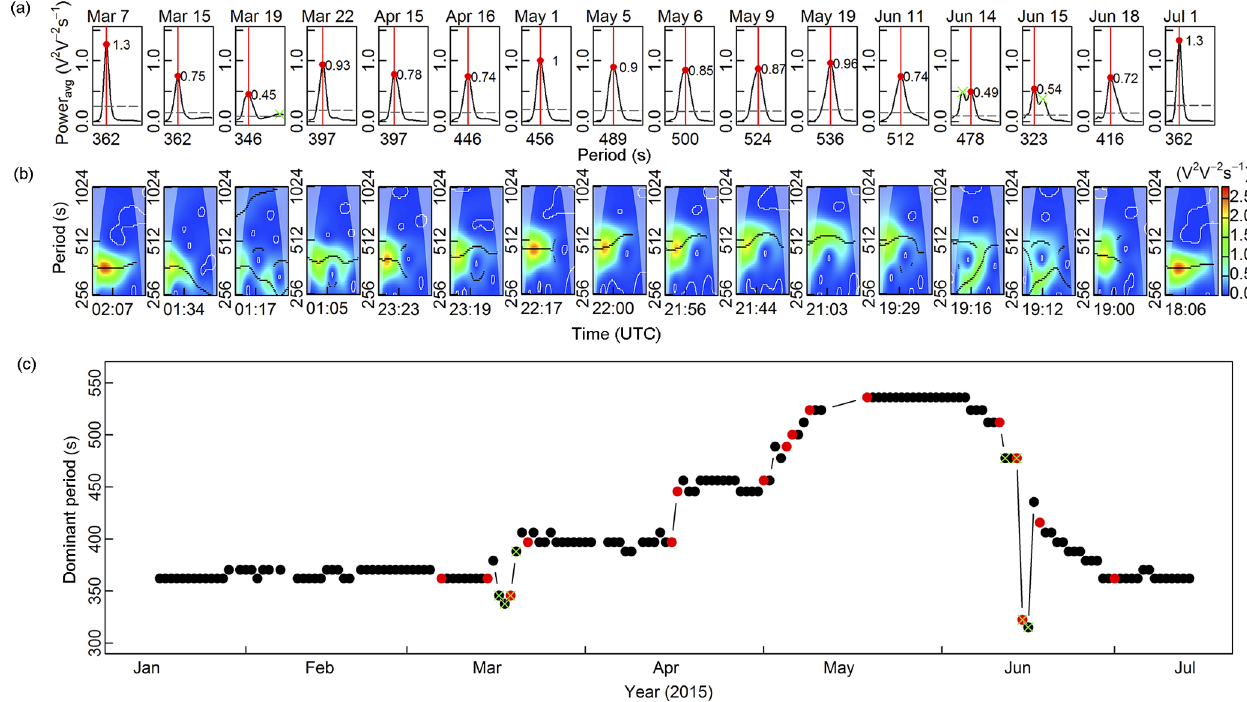
Figure 5. SNR-dominant period ( T d ) time series (black dots in c ) derived from the GPS01 ascending tracks, with the green crosses indicating that more than one peak are recognized as bad quality data, from 16 January to 15 July 2015. (a) the average power spectrums with their maximum values (red dots) and (b) power spectrums on the selected days (red dots in c ) are also shown.